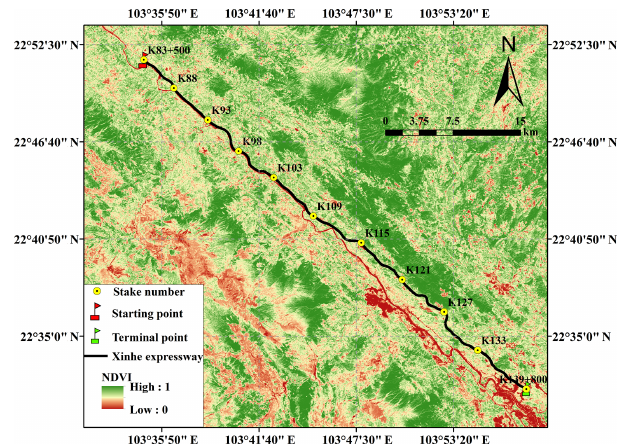
Figure 10. Comparison of model prediction and monitoring results